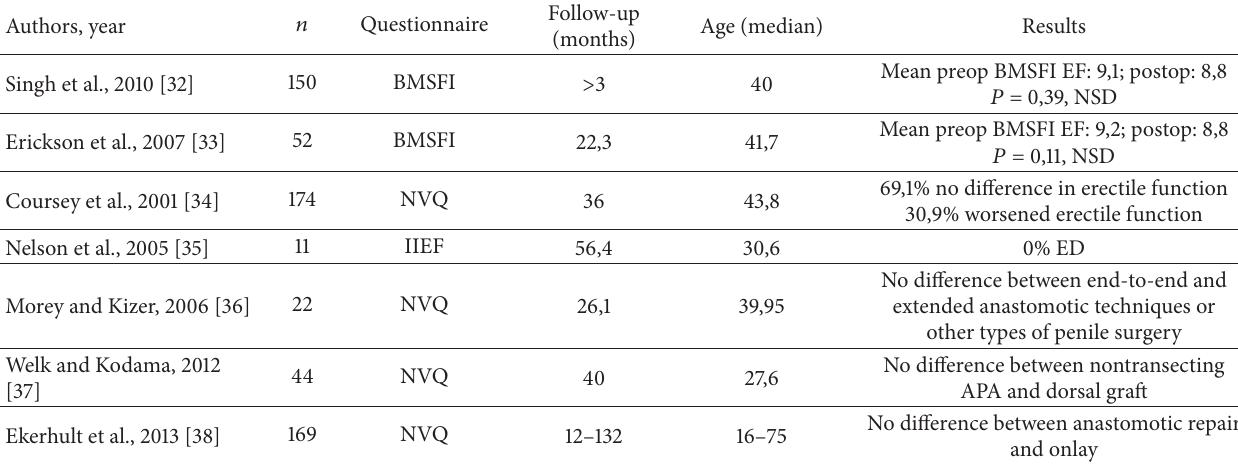
Table 2: Anterior urethra, erectile dysfunction: retrospective studies.